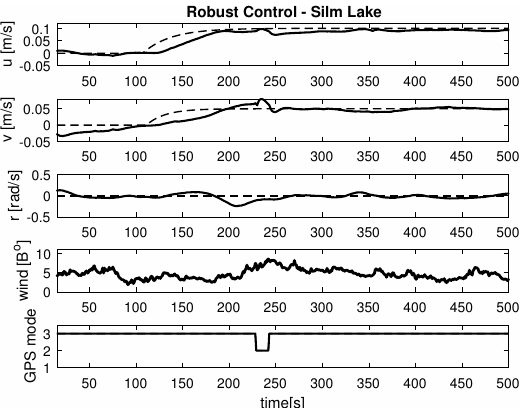
Figure 11. Trajectory ship ‘Blue Lady’ for ahead maneuver with longitudinal velocity u = 0.1 [m/s], v = 0.05 [m/s], r = 0.0 [rad/s], wind [ B o ] and GPS mode [-], maneuver duration 500 [s].